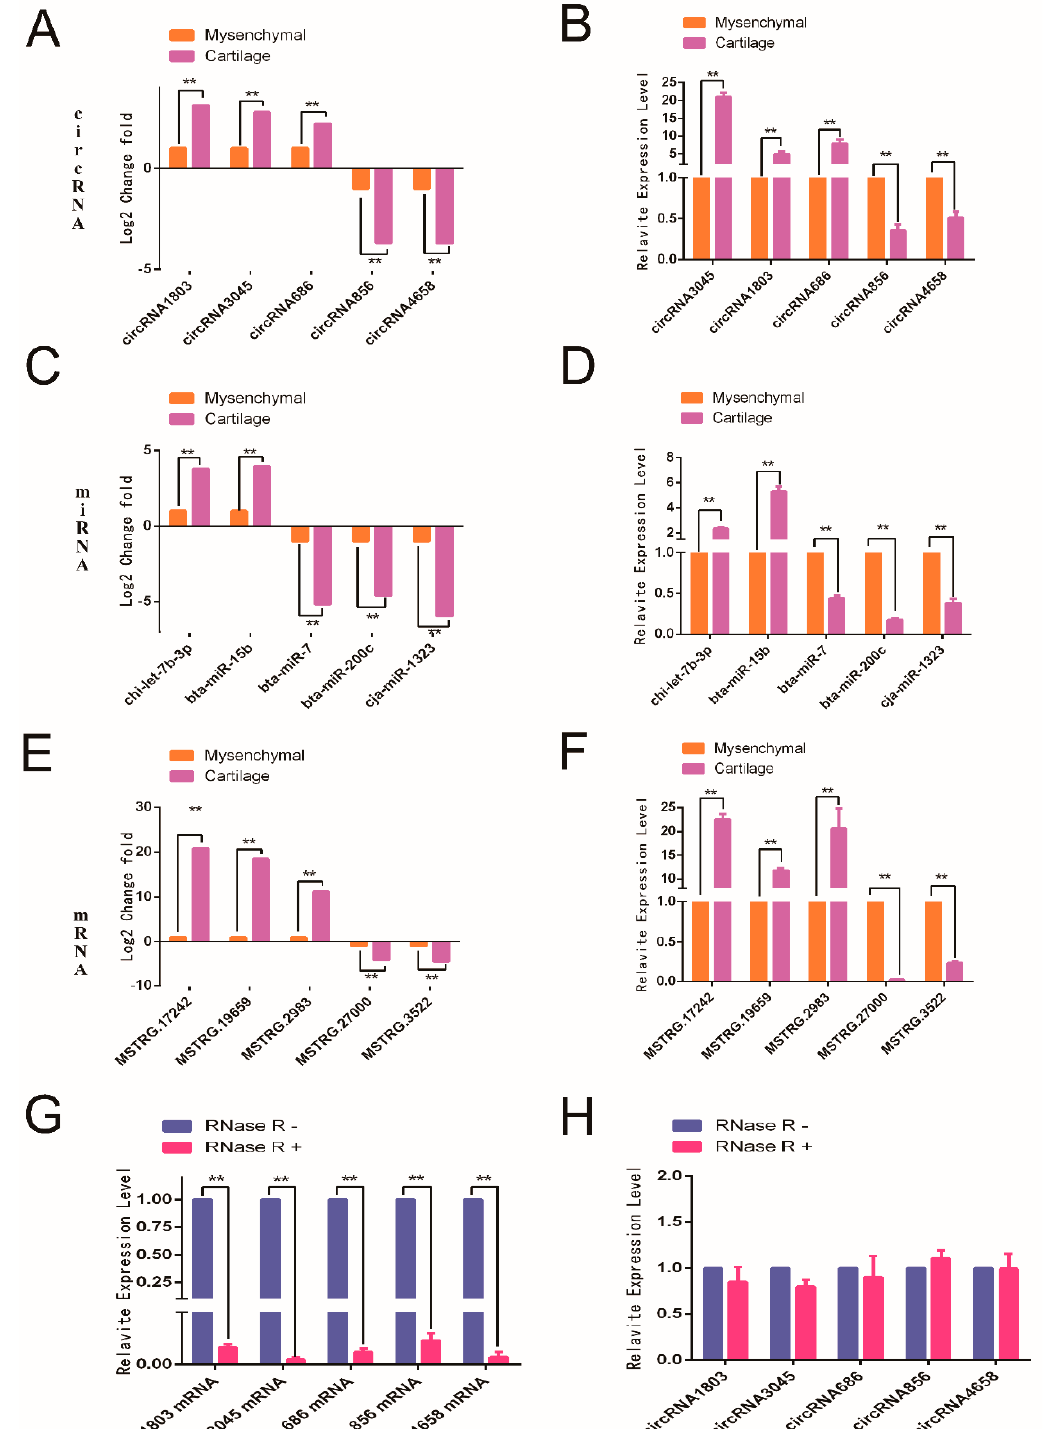
Figure 2. Validation of high-throughput sequencing results. ( A , C , E ) Analysis of the expression levels of circRNA, miRNAs, and mRNAs in high-throughput sequencing results. ( B , D , F ) RT-qPCR validation results of circRNA, miRNAs, and mRNAs. ( G , H ) RNase R digestion followed by RT-qPCR of circRNA and their host genes. ** p < 0.01.